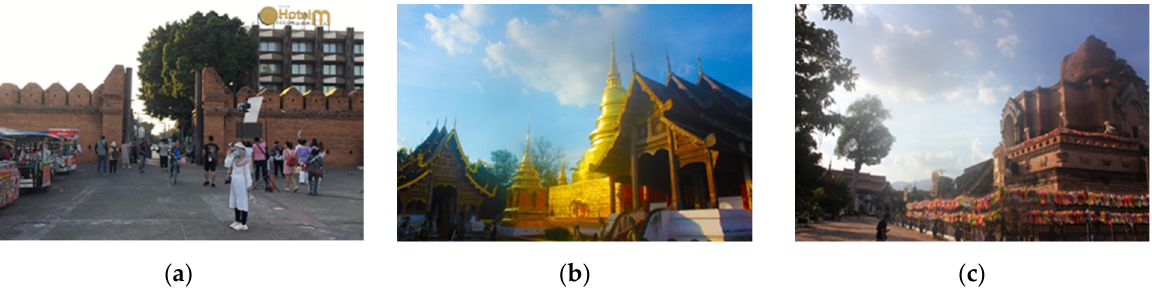
Figure 7. ( a ) Tha-Pare Gate Square (Author); ( b ) Pra singha (Author); ( c ) Chedi Luang Temple (Author). Identity